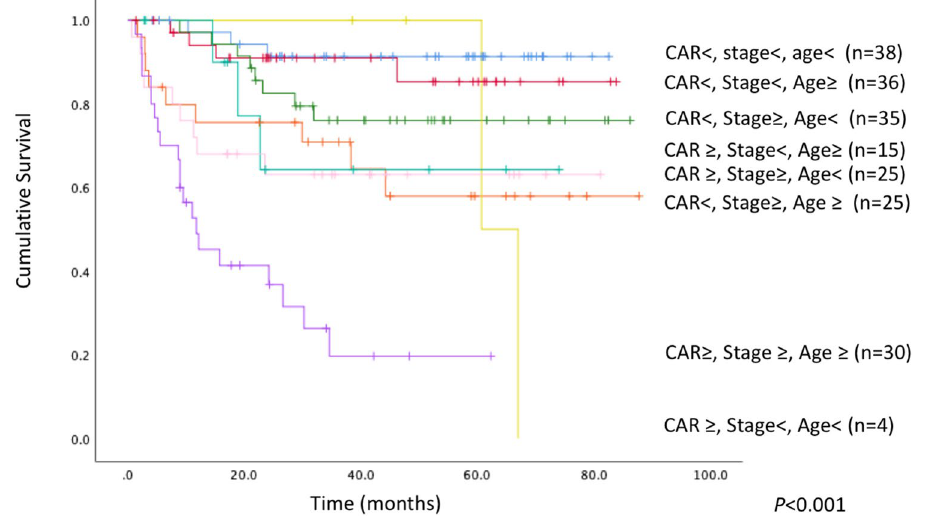
Figure 3. Kaplan–Meier survival curve according to a combination of CAR (< 0.032 or ≥ 0.032), stage (I, II or III, IV), and age (< 71.3 or ≥ 71.3). There were significant differences in OS when the patient cohort was stratified according to a combination of CAR and stage (OS rates: CAR <, stage <, age <, 91.3%; CAR <, stage <, age ≥, 85.3%; CAR <, stage ≥, age <, 76.0%; CAR ≥, stage <, age ≥, 64.3%; CAR ≥, stage ≥, age <, 63.1%; CAR <, stage ≥, age ≥ 58.0%; CAR ≥, stage ≥, age ≥, 19.7%; CAR ≥, stage <, age <, 0%; P <